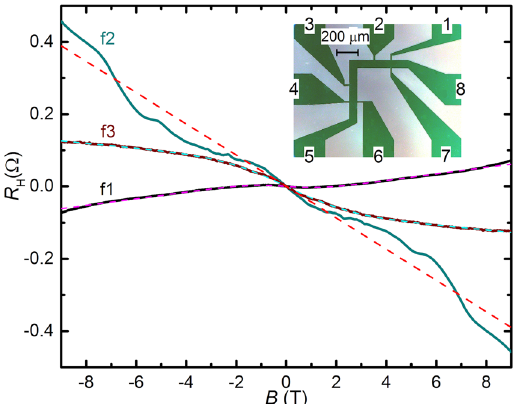
Figure 5. Hall resistance R H vs B at T = 0.39 K for films f1, f2 and f3 (solid lines, films as indicated), with fits to a two-carrier model (f1, f3, dashed lines) or an averaging single-carrier model (f2, dashed line). The polarities are chosen such that a negative slope corresponds to positive charge carriers. The inset represents the L-shaped Hall bar geometry used on all 3 films (contacts 5 and 8 are current contacts, contacts 1, 2, 3, 4, 6, 7 are voltage contacts for measurement of R H and R □